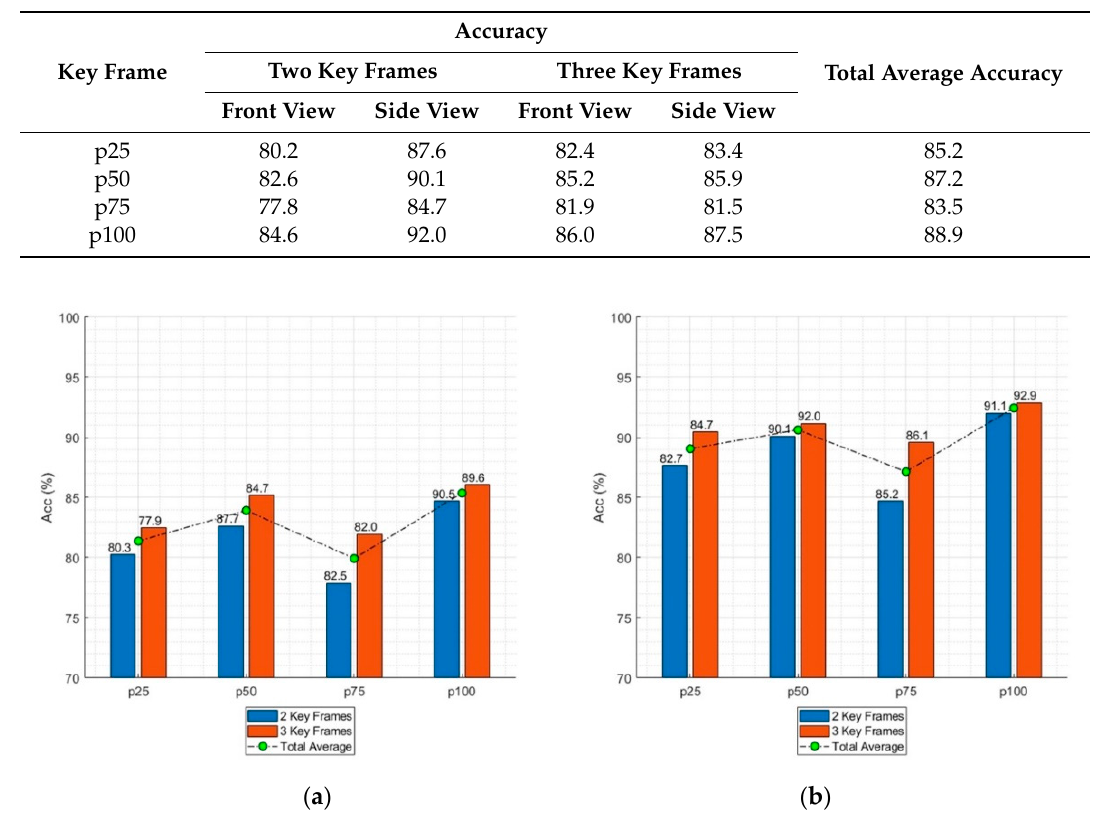
Figure 12. Average accuracy by key frames for each camera view: ( a ) front and ( b ) side.